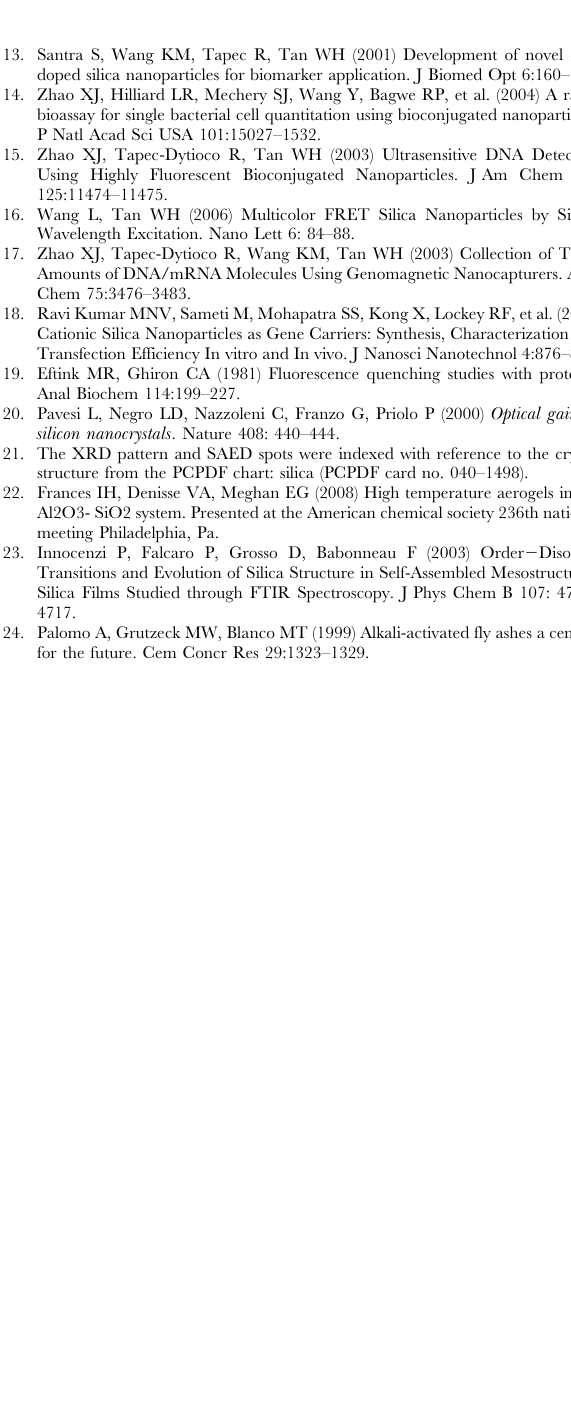
Figure S1 UV-vis spectroscopy(A), XRD(B) measure- ments, TEM(C) and PL(D) analyses of filtrate in the absence of Fusarium oxysporum